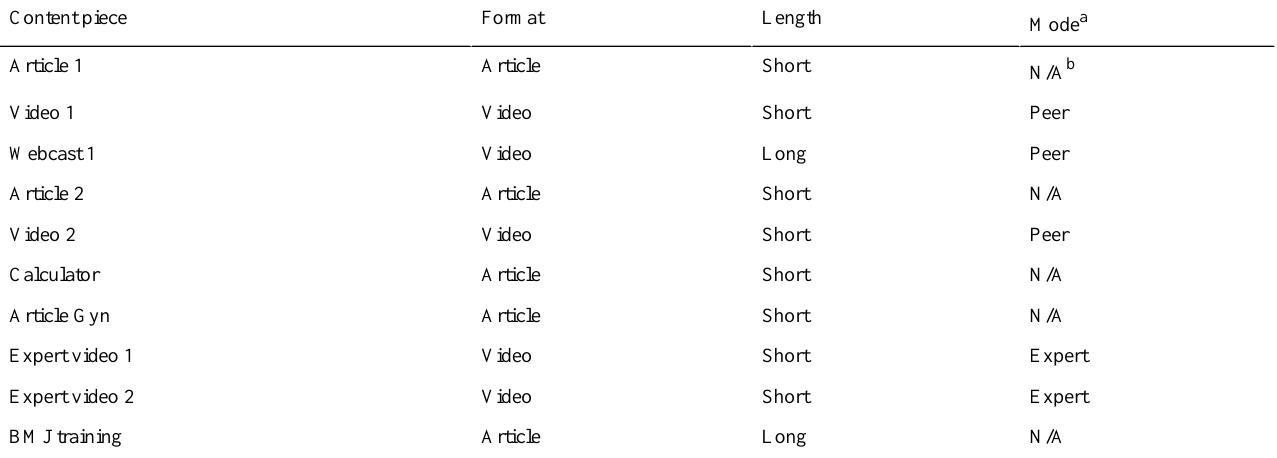
Table 2. Categorization of content